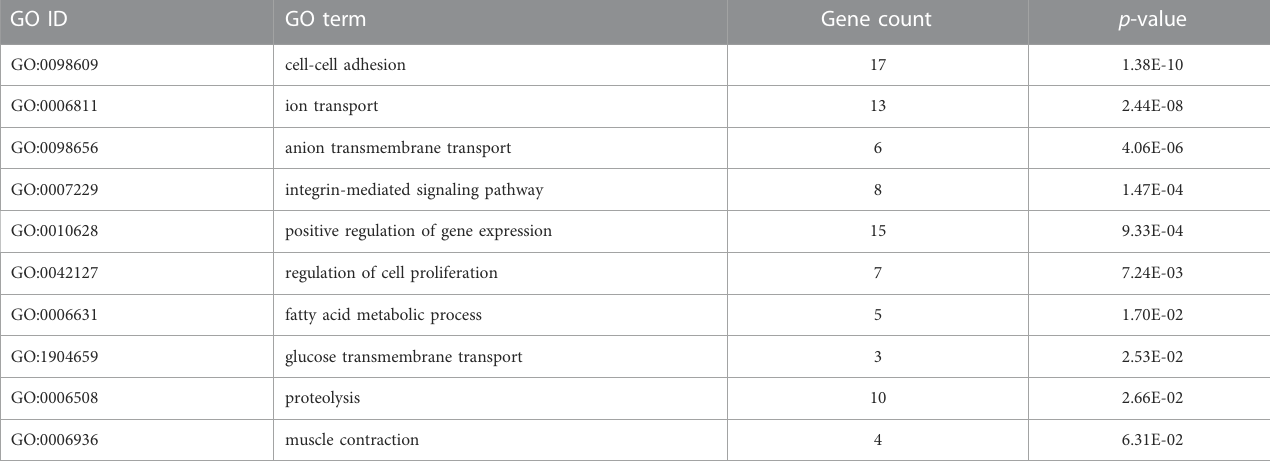
TABLE 1 Biological process GO terms of differentially expressed transcripts between the vehicle vs. cortisol groups. GO ID